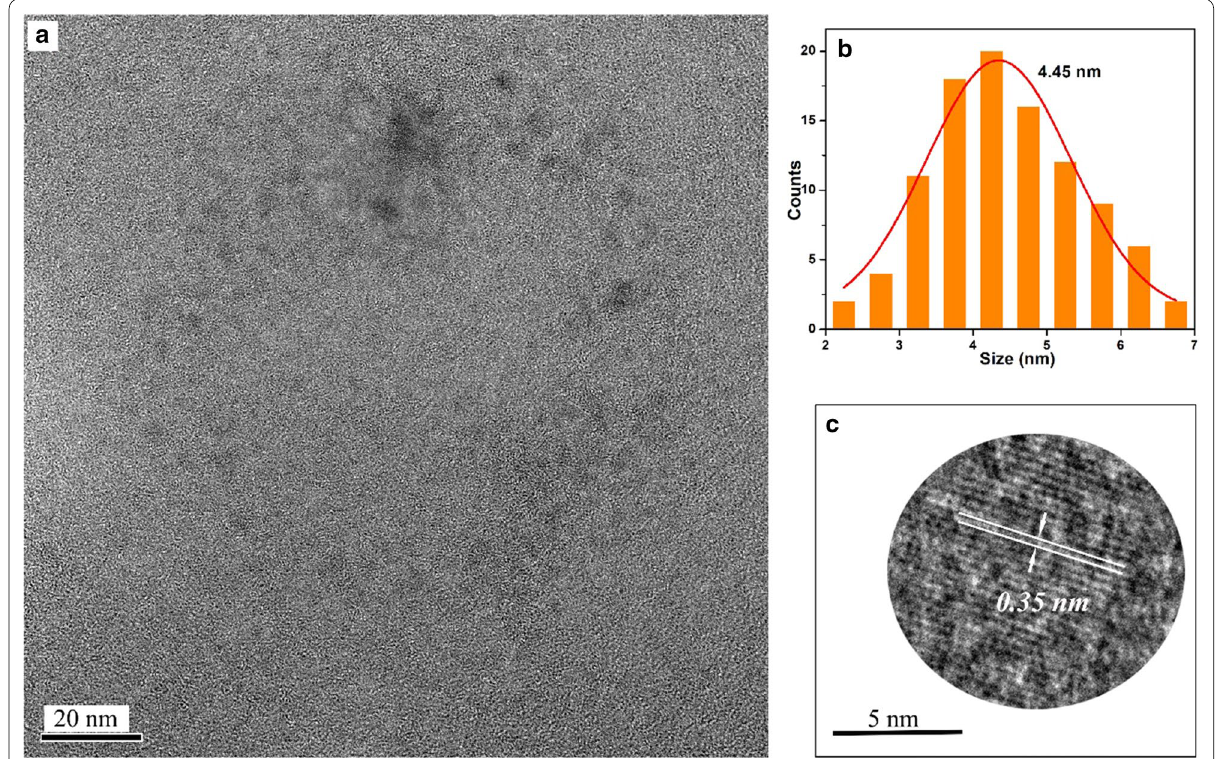
Fig. 4 a TEM images of A p -CDs, b the particle size distribution histograms, and c HR-TEM images